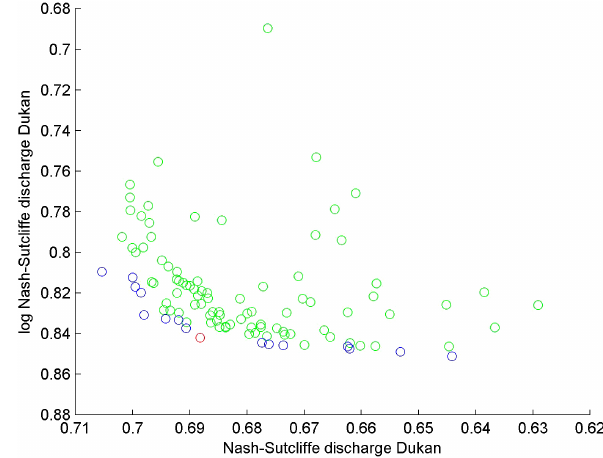
Figure 6. Pareto front for the performance indicators for river flow at the inflow of Lake Dukan. The NS model performance is given on the y axis and the log NS model performance on the x axis. The blue dots represent the models on the Pareto front and the red dot the chosen optimal solution. The green dots represent the ex- tra points on the three-dimensional Pareto front if the NS perfor- mance of GRACE is added as a third calibration parameter. The relatively small spread of the resulting performance indices shows that the model produces consistent results for low/high discharges and GRACE